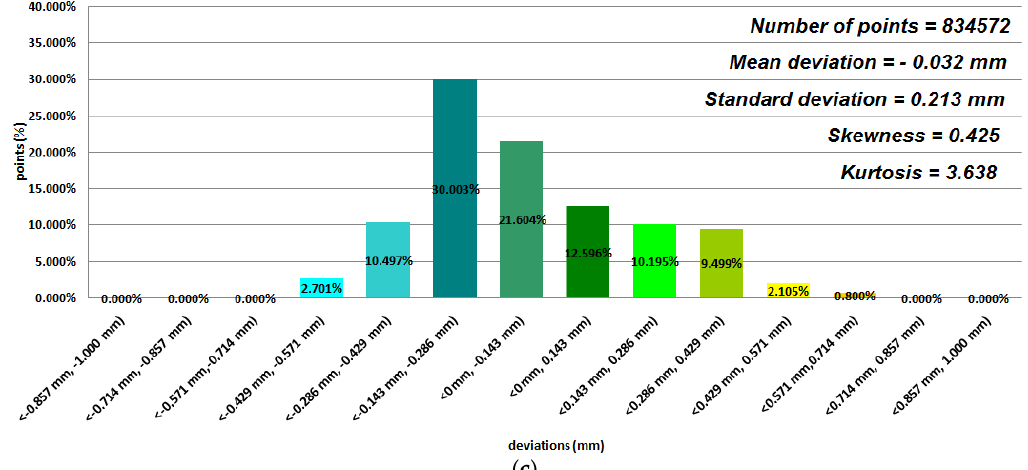
Figure 4. Histograms representing average results of the 12 mandible structures: ( a ) ABS M-30 material; ( b ) PC-10 material; ( c ) Polylactic acid (PLA) material.